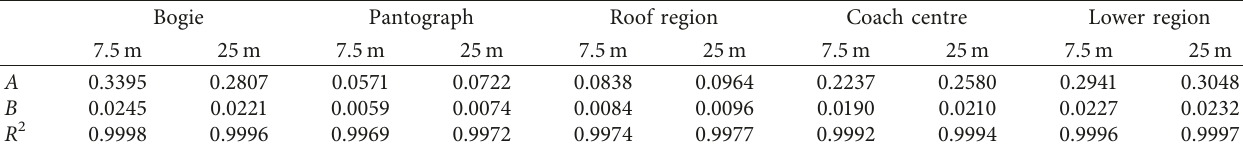
Table 5: Fitting results for the pass-by noise under different noise control